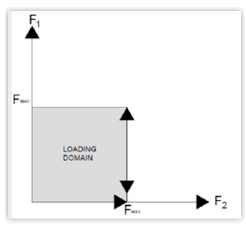
Figure 3. Loading Domain.